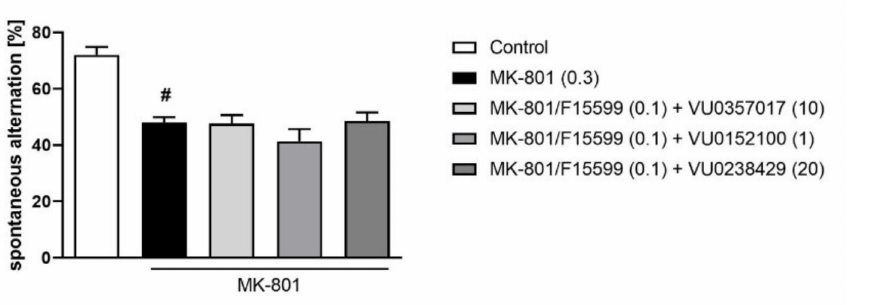
Figure 7. Activity of the combined administration of subeffective dose of F15599 with subeffec- tive dose of VU0357017, VU0152100, or VU0238429 in the Y-maze test. The data are presented as means ± SEM. Doses of the compounds are indicated in parentheses. # p < 0.001 compared to control animals.